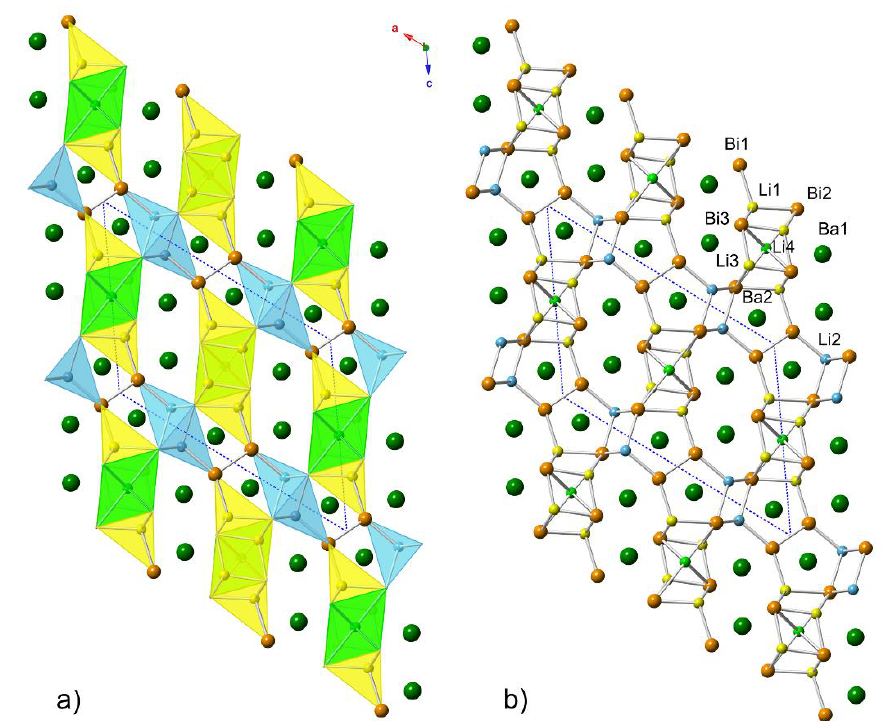
Figure 1. ( a ) Polyhedral representation of the crystal structure of the “4-7-6” family of pnictides, viewed down the crystallographic b -axis. The unit cell is outlined. The data used to represent the structure are taken from the refinement of Ba 4 Li 6.55 In 0.45(1) Bi 6 . Different types of atoms are differentiated as follows: Ba atoms are shown in medium-green, the Bi atoms are in orange, the Li atoms in tetrahedral coordination are drawn in yellow (Li1 and Li3, remnants of the “1-3-2” slab) and light blue (Li2, remnants of the “3-4-4” slab), while the Li atoms in octahedral coordination are depicted in light-green. ( b ) Ball-and-stick representation of the same structure in the same projection. Table 4. Selected distances (Å) in crystal structures of the “4-7-6” family of pnictides a . Atom